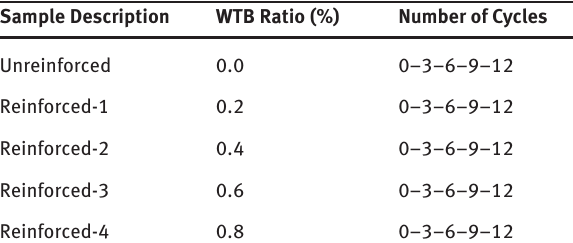
Table 2: Prepared samples, WTB ratios and number of freezing– thawing